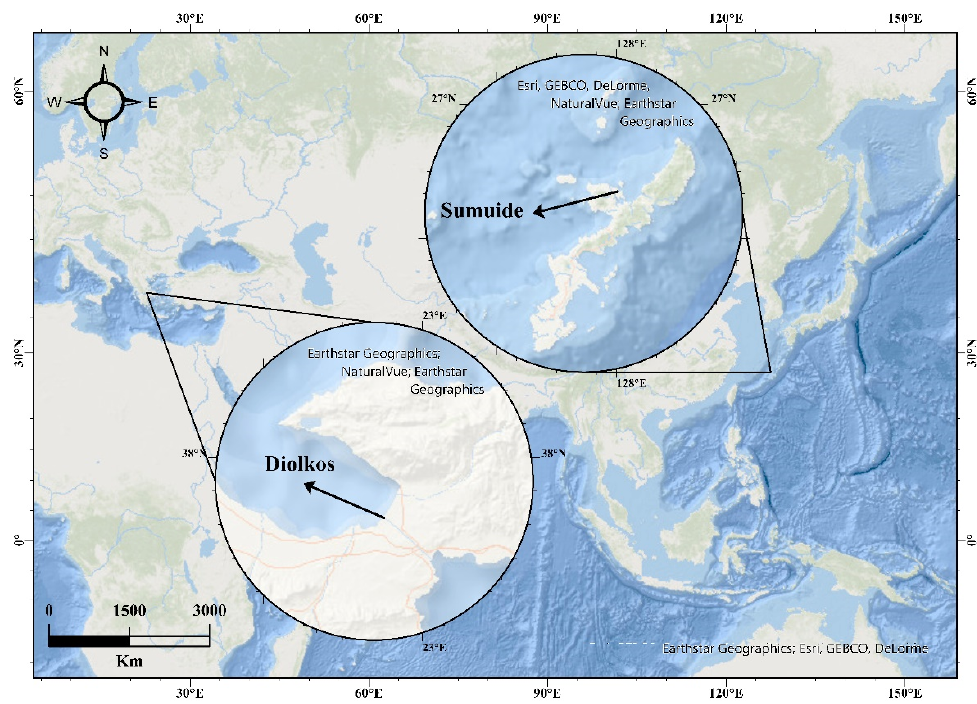
Figure 1. Location of study areas. In the west is Diolkos, Corinth, Greece, while in the east is Sumuide, Okinawa Island, Japan.